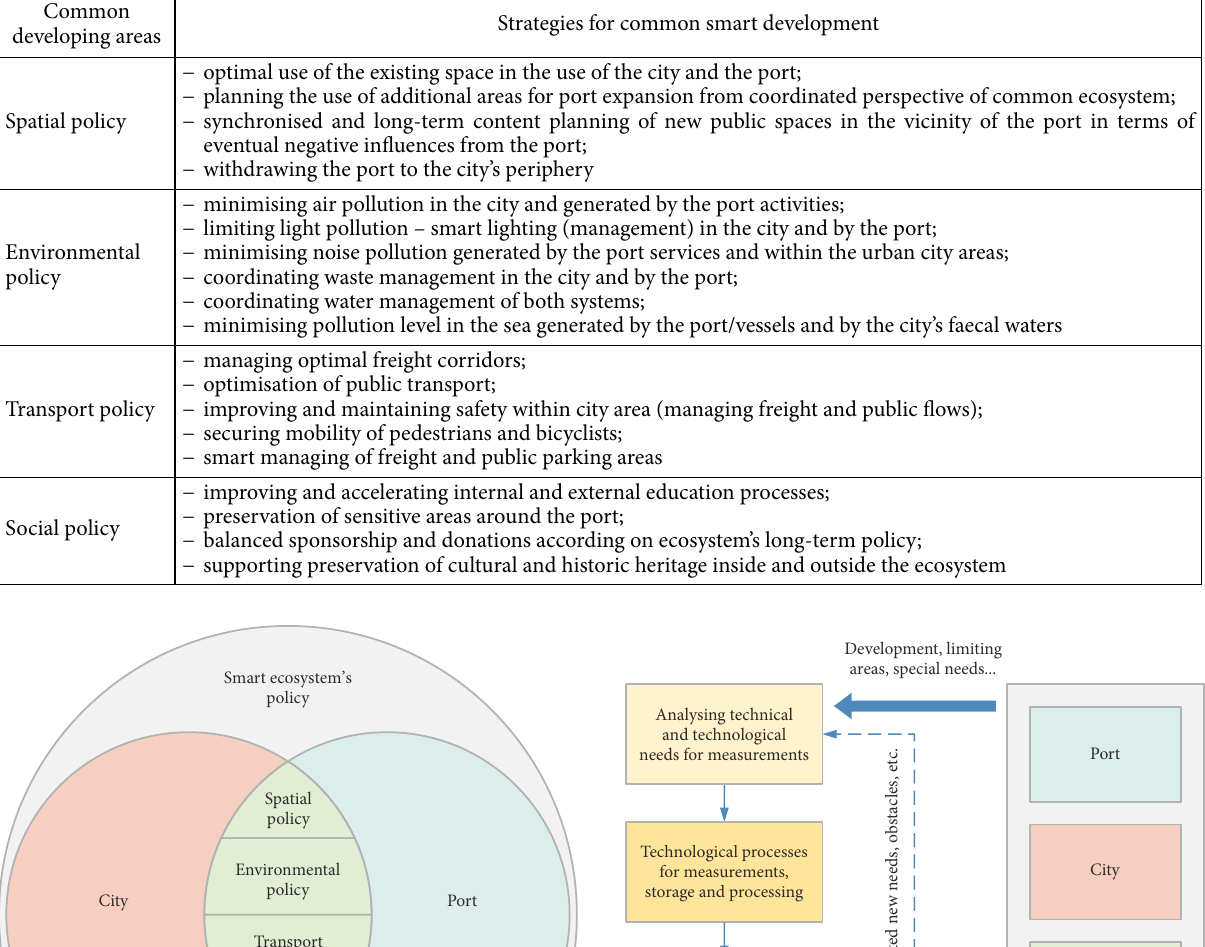
Table 3. Main strategies for coordinated SCP ecosystem development (source: based on analysed literature) Common developing areas